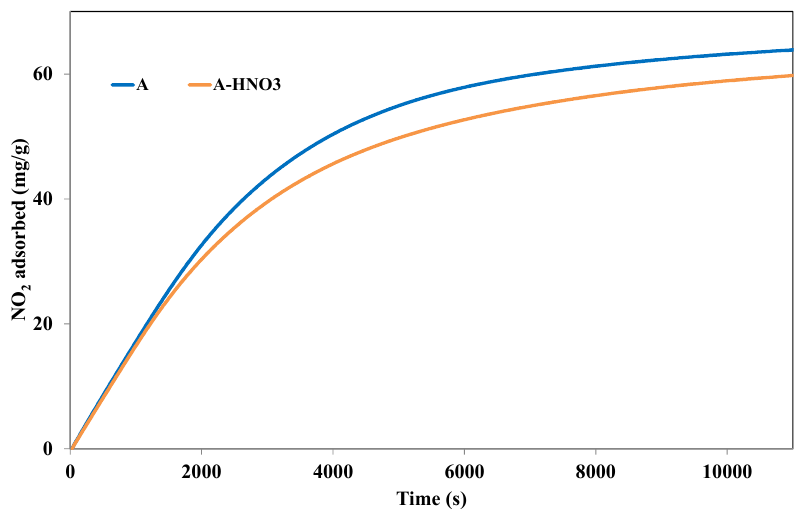
Figure 11. Evolution of the amount of NO 2 adsorbed at the surface of the activated carbon treated with HNO 3 and the activated carbon A, at 25 °C and until saturation.